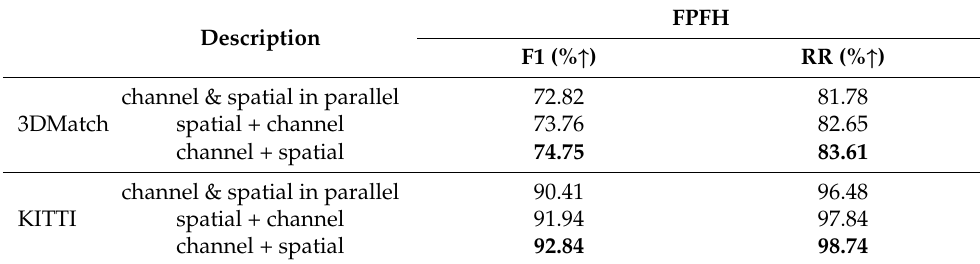
Table 4. Combining methods of the channel and spatial attention. The ‘+’ indicates a serial con- nection here and the ‘&’ indicates a parallel connection. The test results are combined with the FPFH